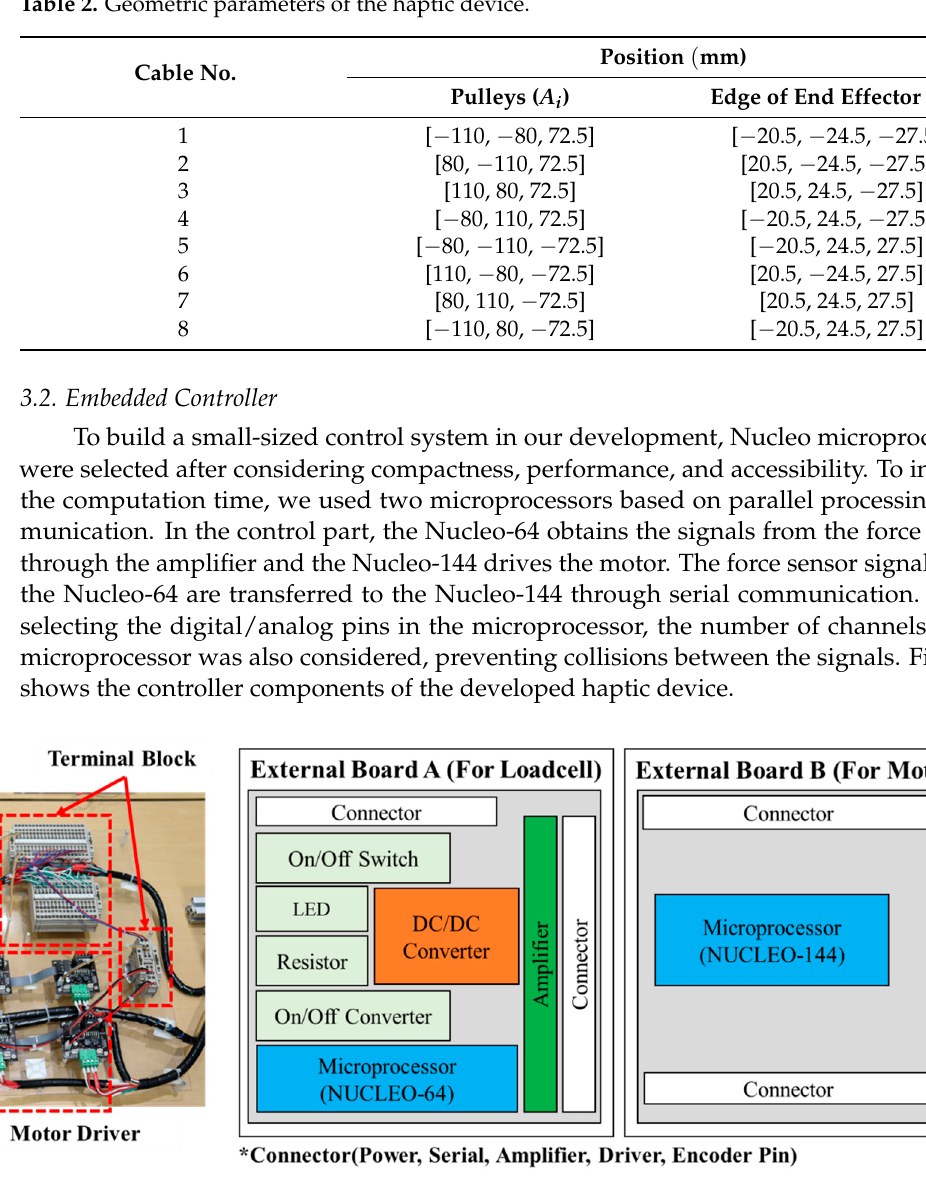
Table 2. Geometric parameters of the haptic device.